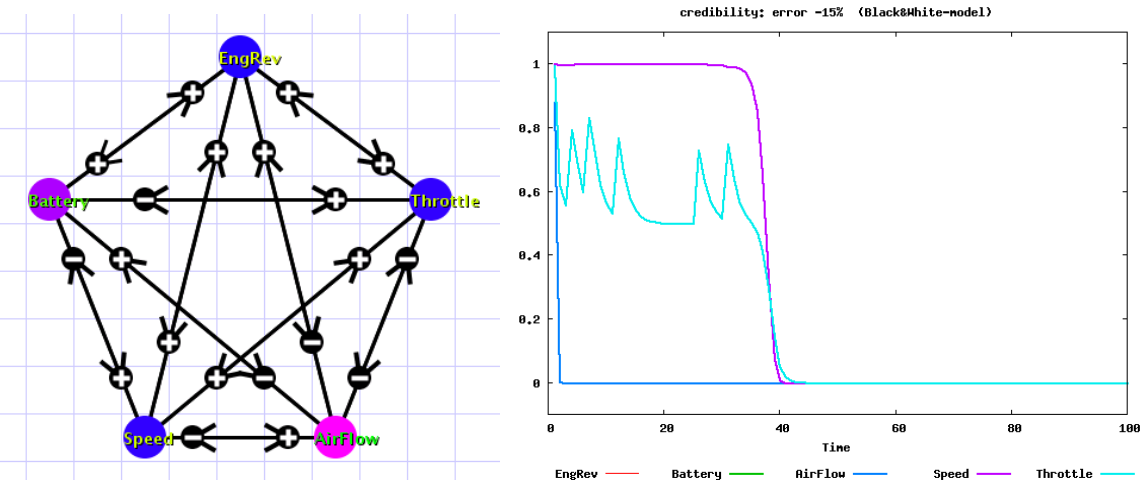
Figure 2. The left network is a snapshot used for trial diagnosis. The sign attached to each arc is a snapshot of evaluation based on the sensor data. The node color indicates credibility: blue nodes correspond to high credibility, and red nodes to low credibility (i.e. evaluated as faulty) (left). The right plot shows diagnosis by the network when the air flow sensor is faulty. The plotted line shows the time evolution of credibility for the sensor; although the credibility for the faulty sensor is evaluated as low (0), those of other sensors are also dragged to 0 (right) [6]. © 2006